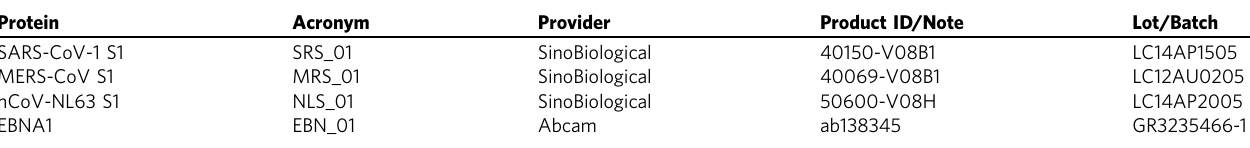
Table 2 Proteins from other